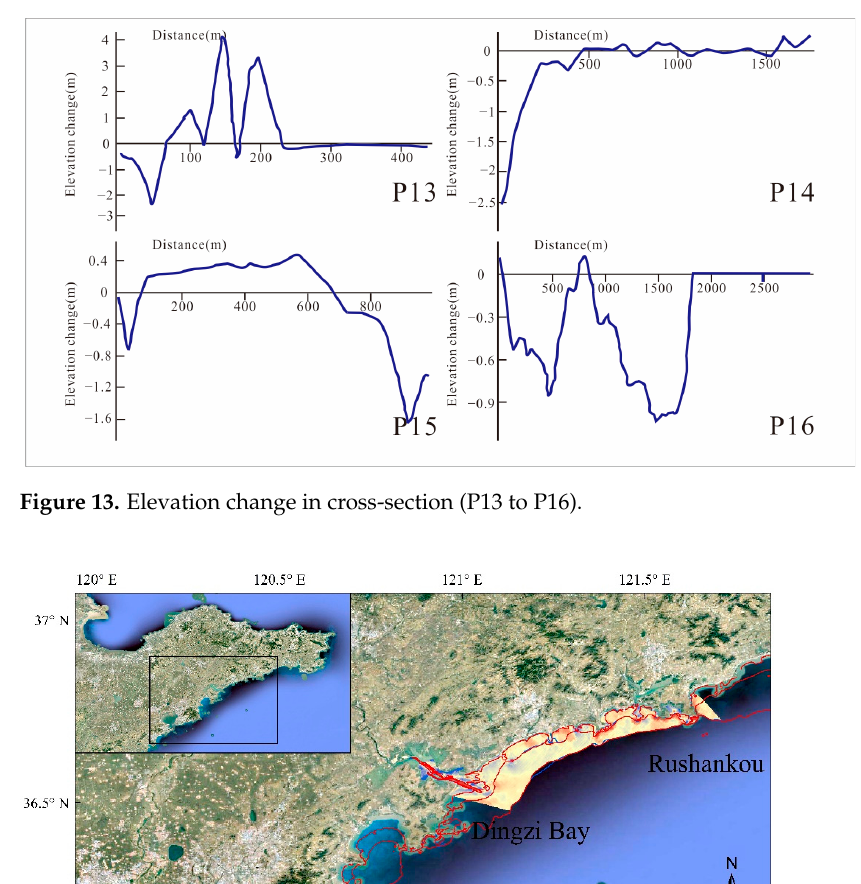
Figure 12. Elevation change in cross-section (P09 to P12).